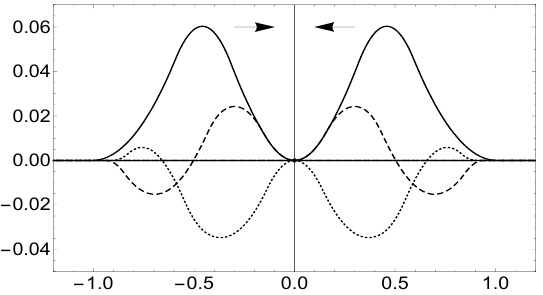
Figure 9 . Symmetric initial con(cid:12)gurations of the oscillons (cid:9) ( s ) ( x ) at t = 0 when their supports begin to collide. The con(cid:12)gurations correspond to v = 0 : 2, V = 1 oscillations are given by (cid:11) = 0 (solid line), (cid:11) = 0 : 1772 (dashed line) and (cid:11) = 0 : 6222 (dotted